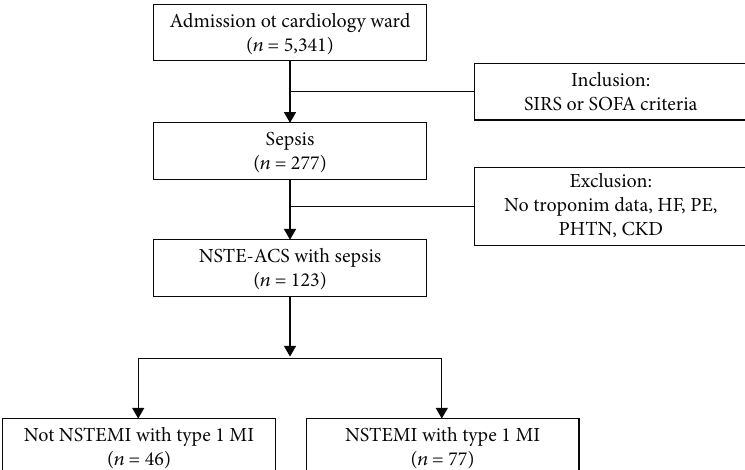
Figure 1: Flow diagram of the selection of study patients. CKD: chronic kidney disease; HF: heart failure; NST-ACS: non-ST-segment elevation acute coronary syndrome; NSTEMI: non-ST-segment elevation myocardial infarction; PE: pulmonary embolism; PHTN: pulmonary hypertension; SIRS: systemic in fl ammatory response syndrome; SOFA: Sequential Organ Failure